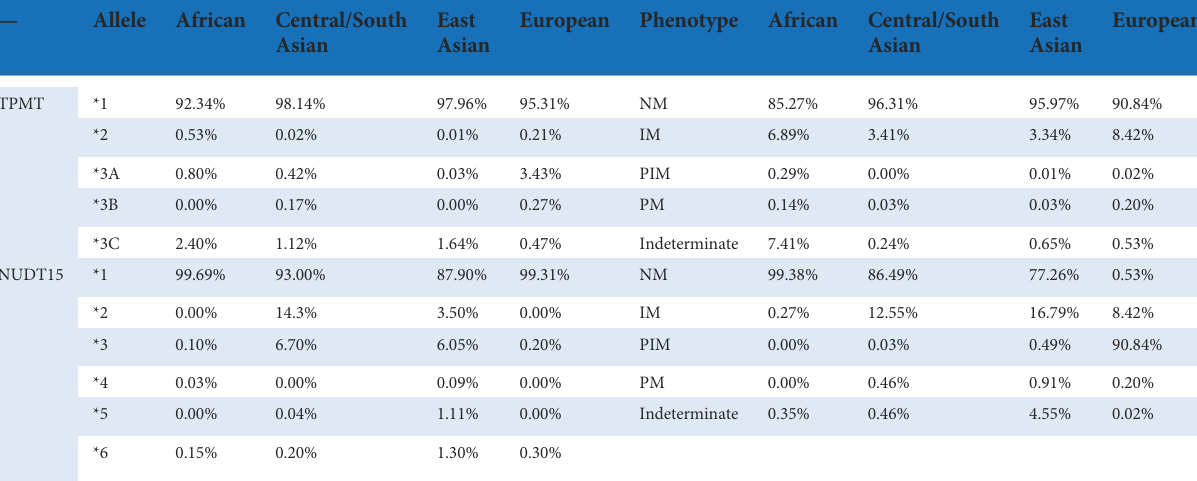
TABLE 1 Frequencies of the TPMT and NUDT15 alleles/phenotypes in major race/ethnic groups. —